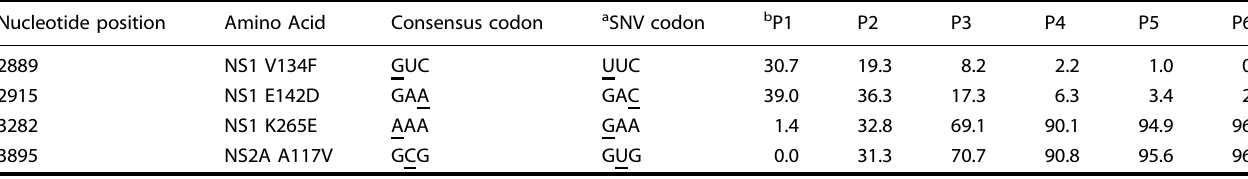
Table 1. Genetic analysis of ZE4B-36 revealed the presence of four high-frequency SNVs following serial passage. Nucleotide position Amino Acid Consensus